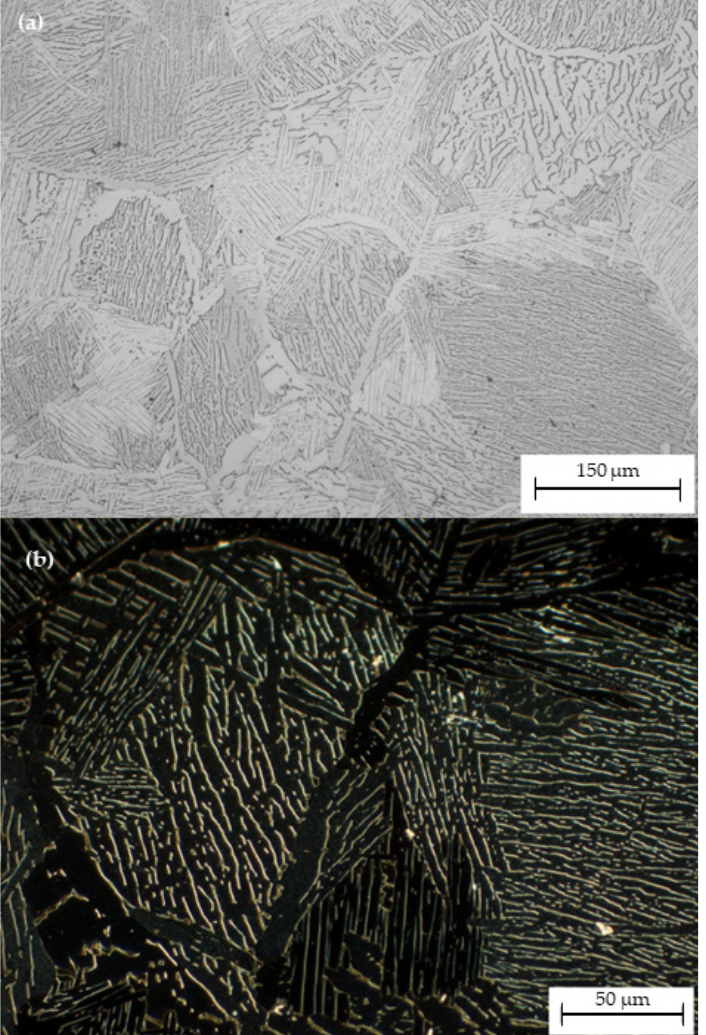
Figure 5. Micrographs showing equiaxed β grains with colonies of α and lamellar α developed after HT-B (925 °C/4 h-@50 °C/h to 760 °C-FC) ( a ) Low magnification micrograph from the optical microscope ( b ) dark field image showing the distribution of β phase.